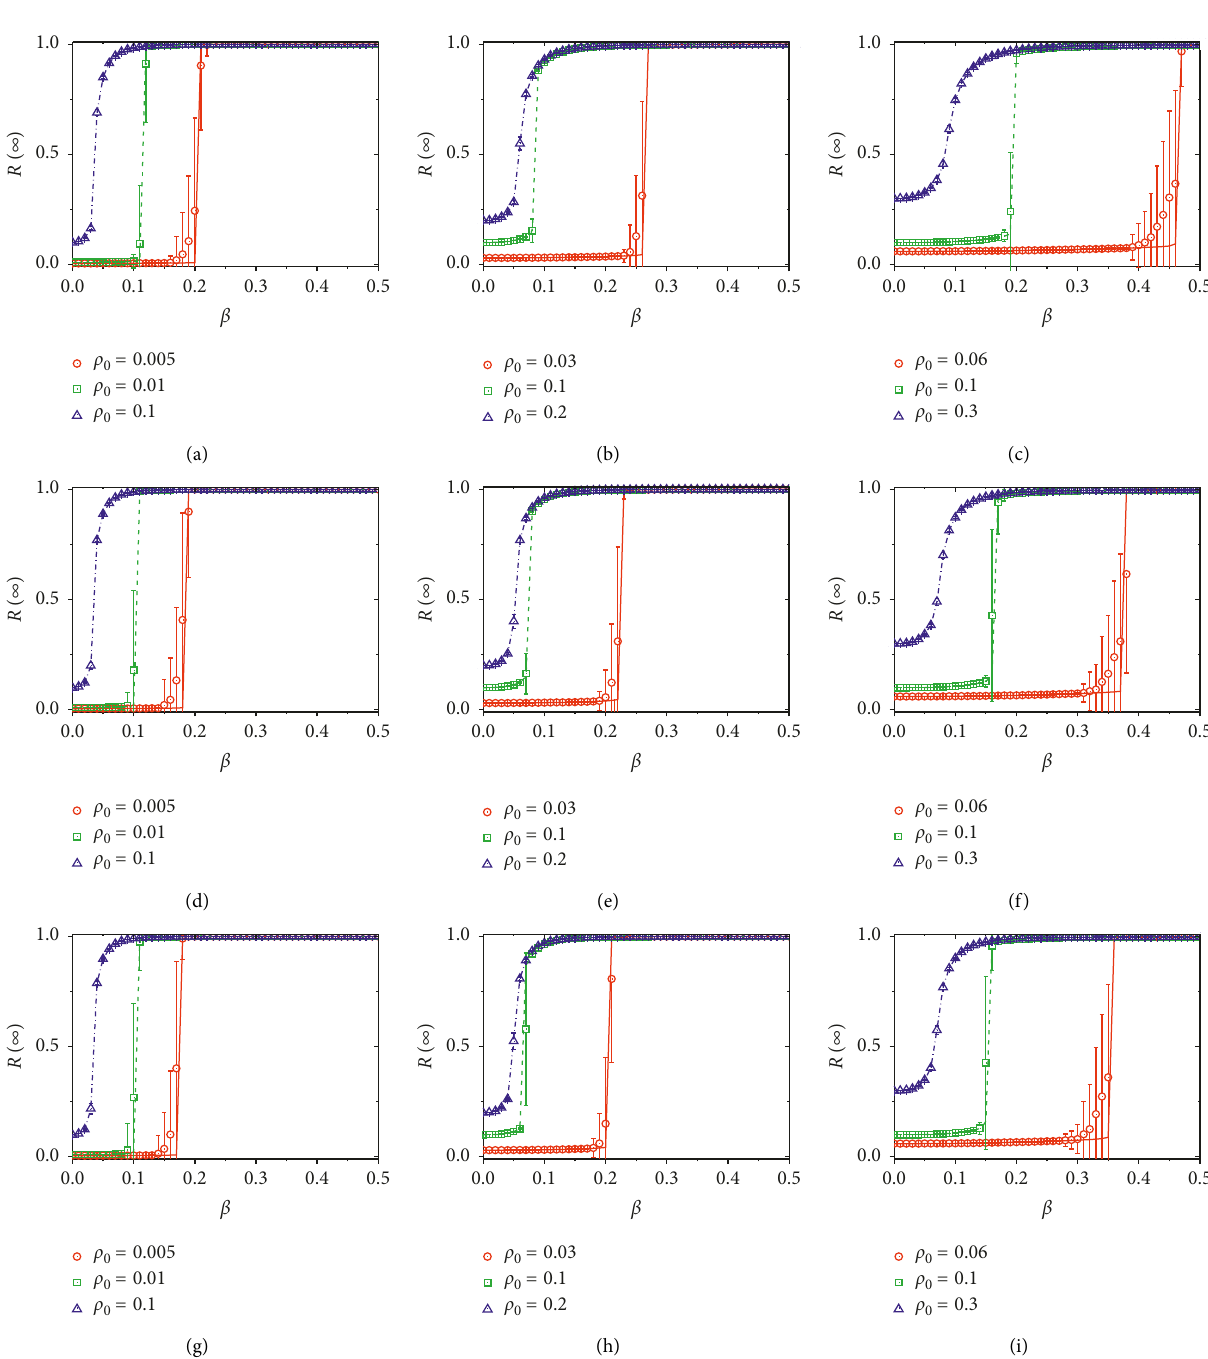
Figure 4: Effect of fraction of initial seeds on the growth pattern of the final adoption size R ( ∞ ) versus β on the ER-ER weighted multiplex network, under different weight distribution exponents α A and α B . The values of weight distribution exponent α A of all subgraphs are 3, and ω ω ω � 2 . 5; (d), (e), and (f) correspond to α B � 3; , i.e., subgraphs (a), (b), and (c) correspond to α B the subgraphs in each row have the same α B ω ω ω � 3 . 5. Additionally, the subgraphs in each column have the same adoption threshold, i.e., subgraphs and (g), (h), and (i) correspond to α B ω (a), (d), and (g) are set with T A � 1 ,T B � 1; (b), (e), and (h) with T A � 1 ,T B � 2; and (c), (f), and (i) with T A � 1 ,T B � 3. The